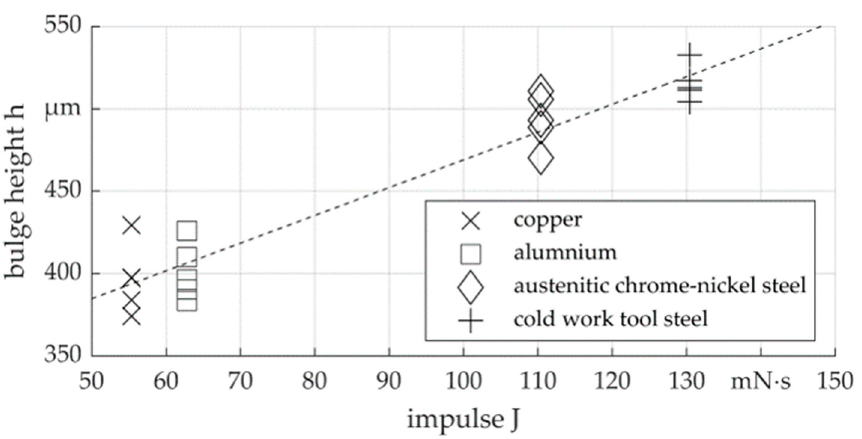
Figure 14. Corresponding experimental bulge height h for the simulated impulse J for different die materials with linear correlation line for a 1250 J forming experiment.